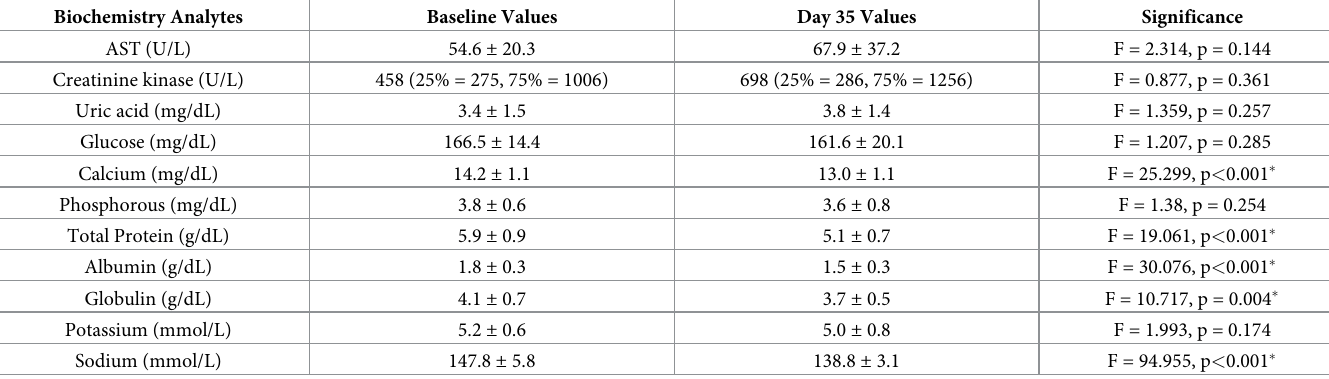
Table 4. Average biochemistry results from all geckos over time (baseline vs. day